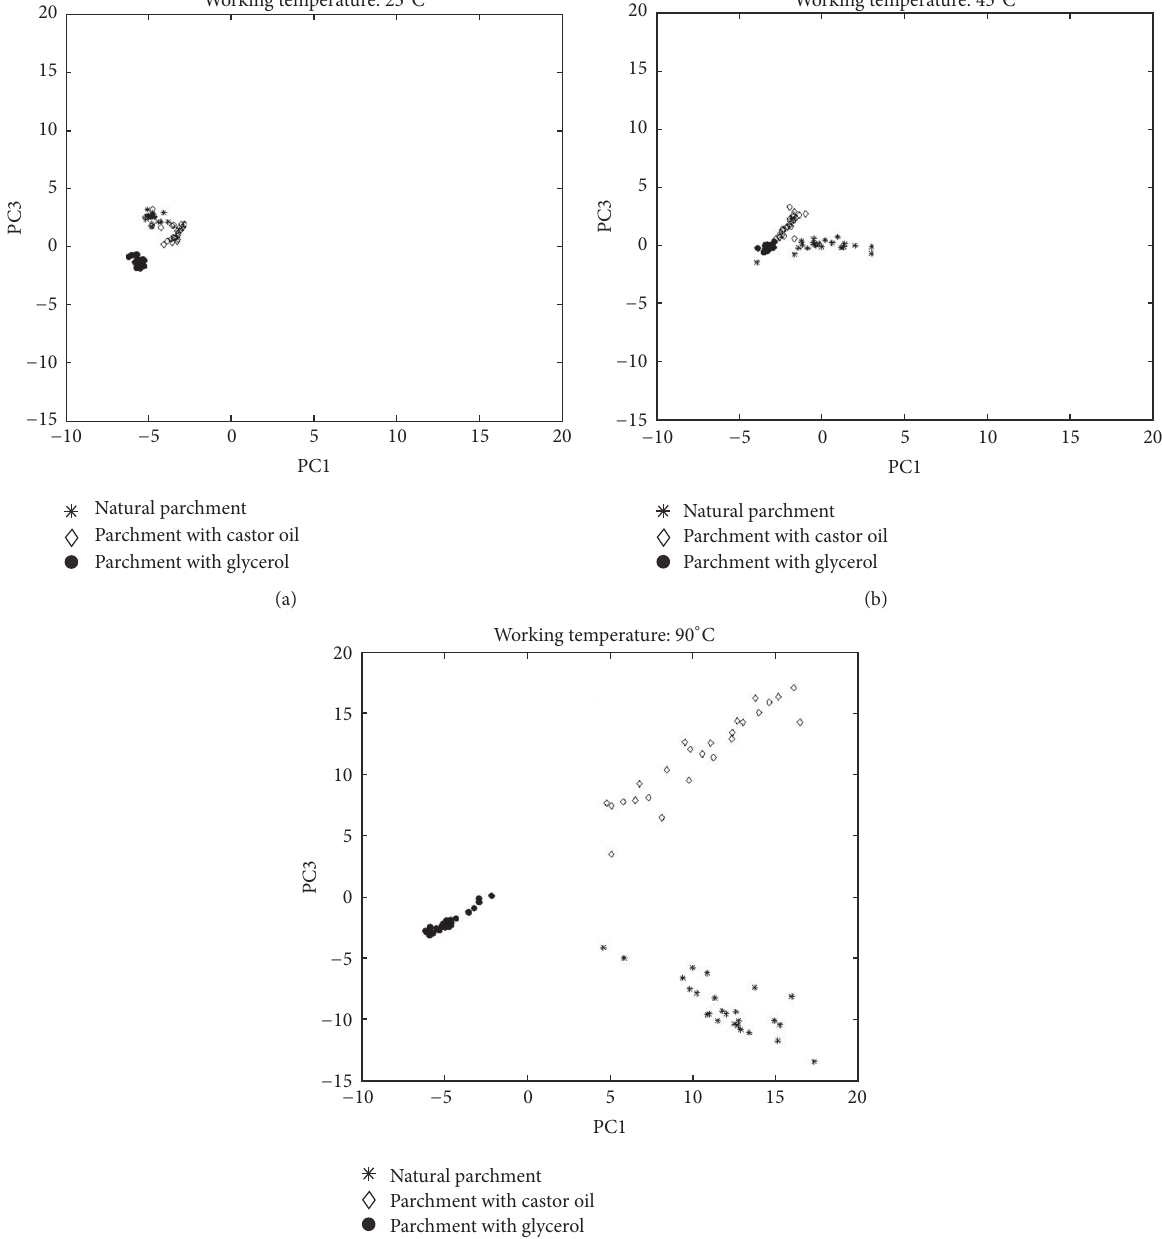
The mass spectra of the different samples matched each other and the results were arranged in a 232 × 5323 matrix: 232 being the number of samples (69 samples analyzed at 23 ∘ C, 78 samples analyzed at 45 ∘ C, and 85 samples analyzed at 90 ∘ C) and 5323 being the 𝑚/𝑧 intensity count for each sample. PCA was carried out after range scaling between − 1 and